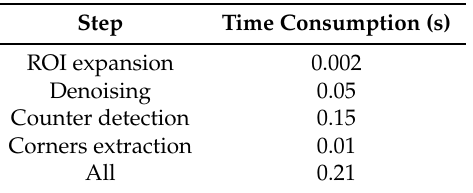
Table 3. Time consumption of each